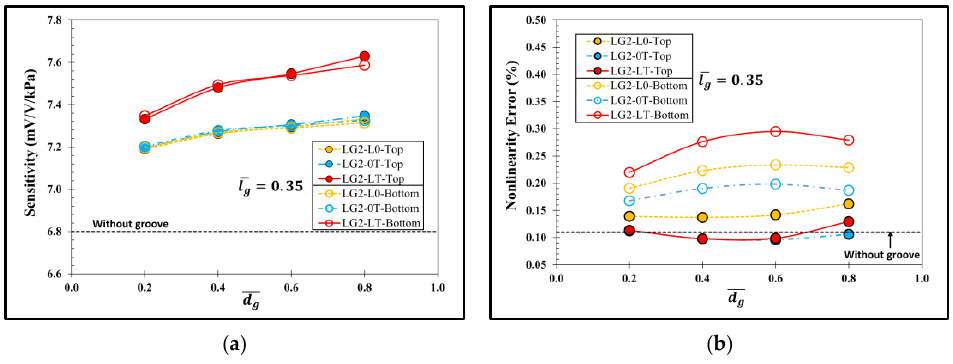
Figure 14. Comparisons of ( a ) sensitivity and ( b ) nonlinearity error between sensors with local groove LG 2 and l g = 0.35 on top and at bottom of